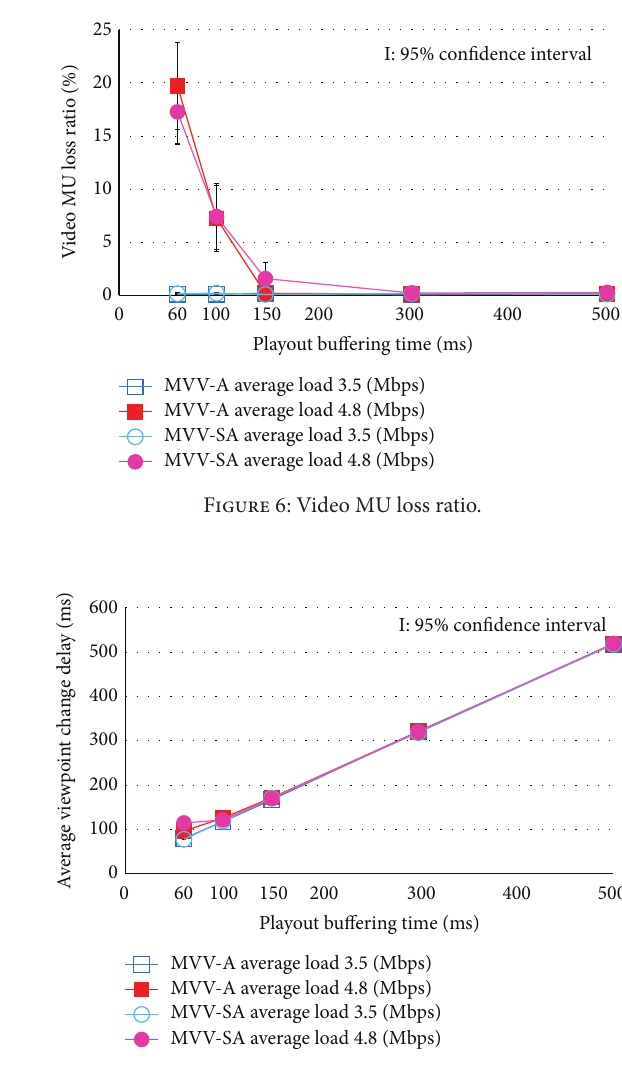
Figure 7: Average viewpoint change delay: additional delay